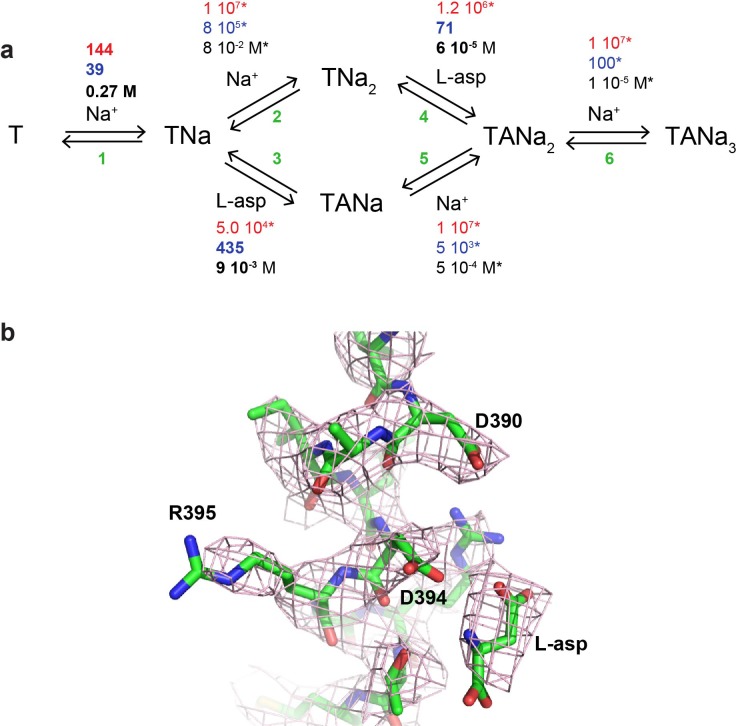
(a) The kinetic model describing L-asp binding to FM-P11WIFS.The binding (red) and unbinding (blue) rate constants and the equilibrium constants (black) are in M−1 s−1, s−1 and M. All kinetic constants marked by stars were fixed to values used to fit L-asp binding data and the fitted constants are highlighted in bold. (b) Shown is a fragment of TM8 of FM-GtPhIFS including residue R395 and bound L-asp. The mesh object is the three-fold averaged sharpened 2Fo-Fc electron density contoured at 1.2 σ.